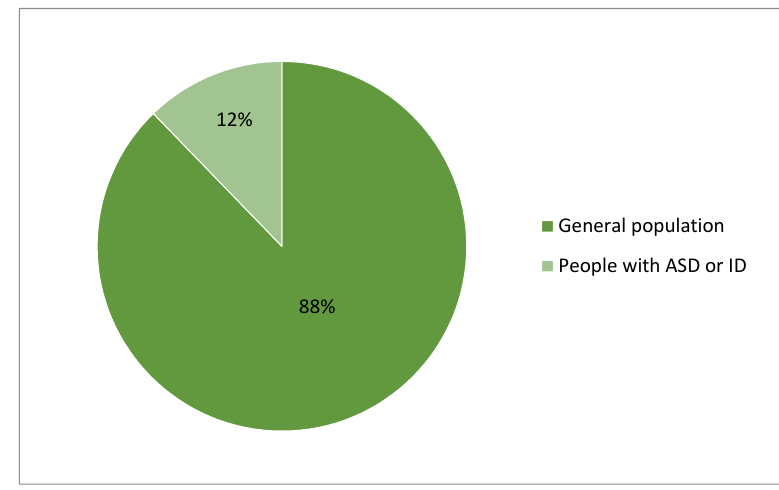
Figure 1. Proportion of products designed for general population vs. people with ASD.